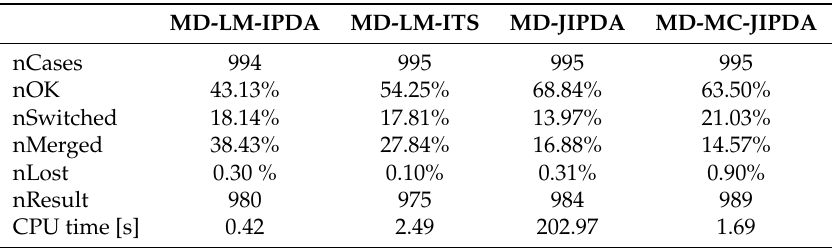
Table 2. Statistic